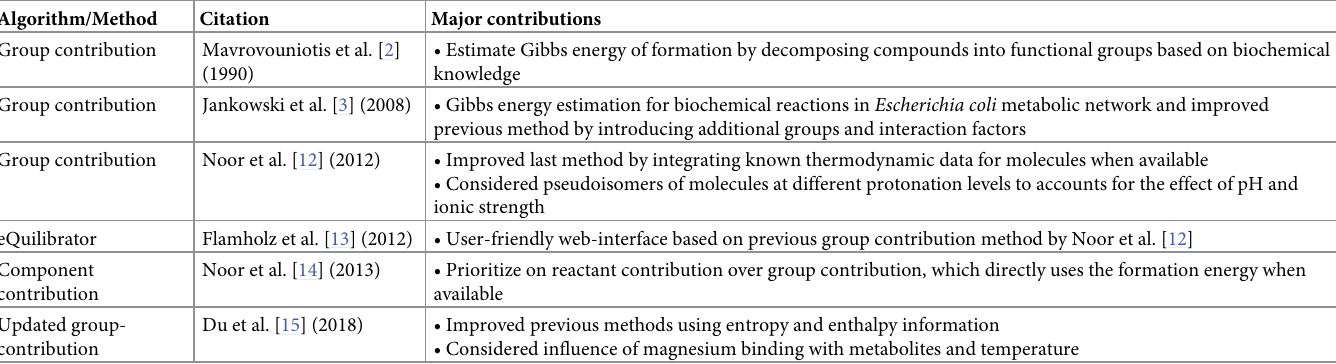
Table 1. Existing methods for the prediction of standard Gibbs energy of biochemical